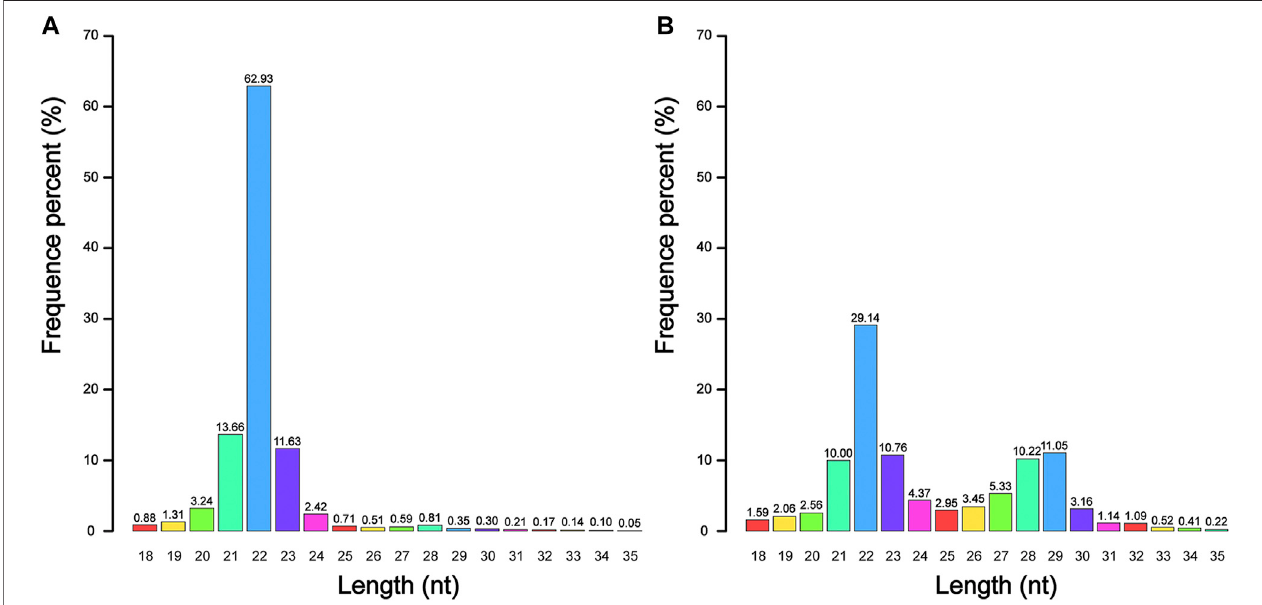
FIGURE 1 | The nucleotide (nt) length distribution of small RNA in adult Chinese alligator ovaries (A) and testes (B) sampled in summer.